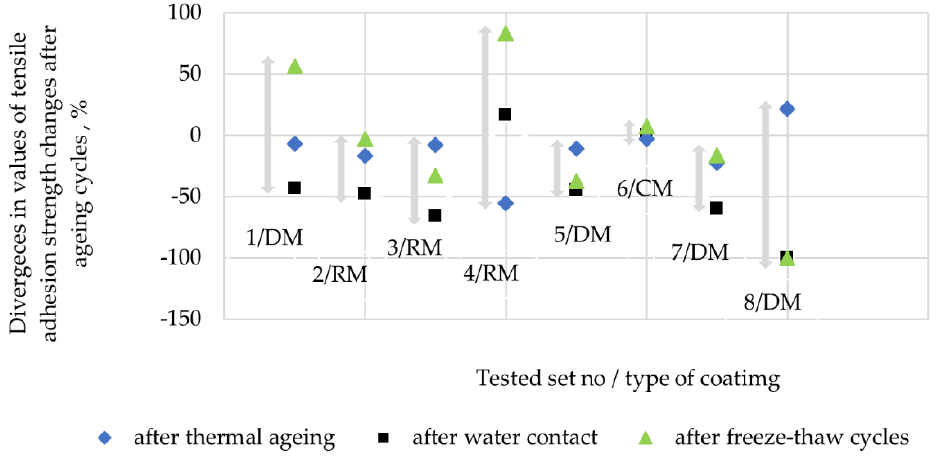
Figure 4. Divergences between extreme change values of tensile adhesion strength changes for waterproofing sets, following exposure to ageing factors, in reference to the initial tensile adhesion strength.